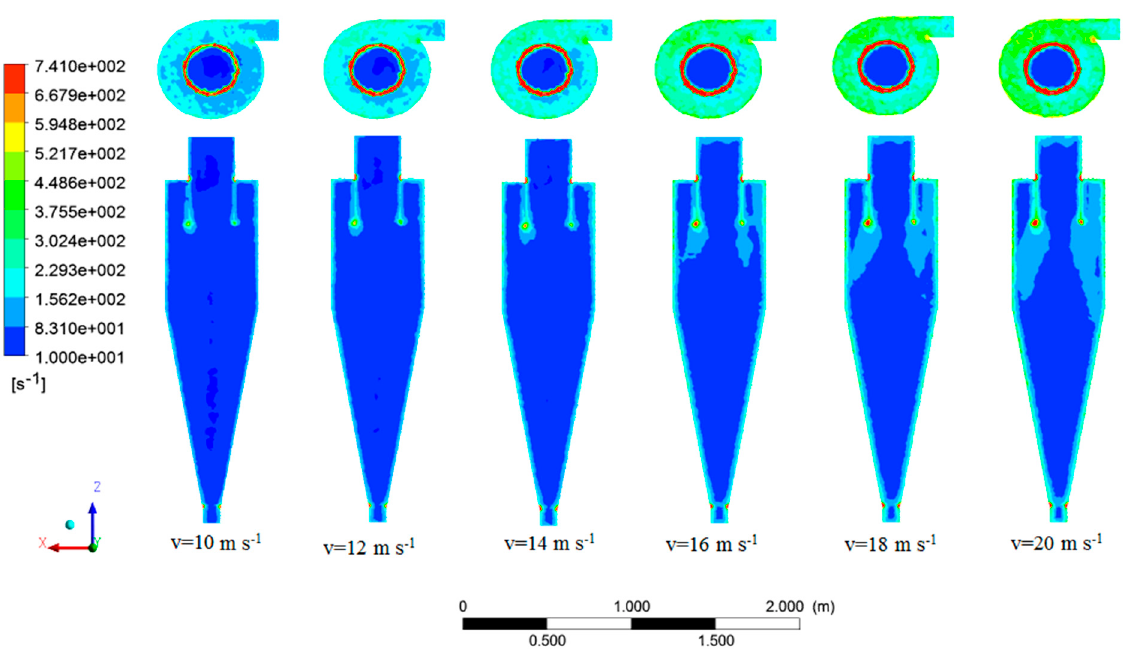
Figure 15. Strain rate contours in various inlet